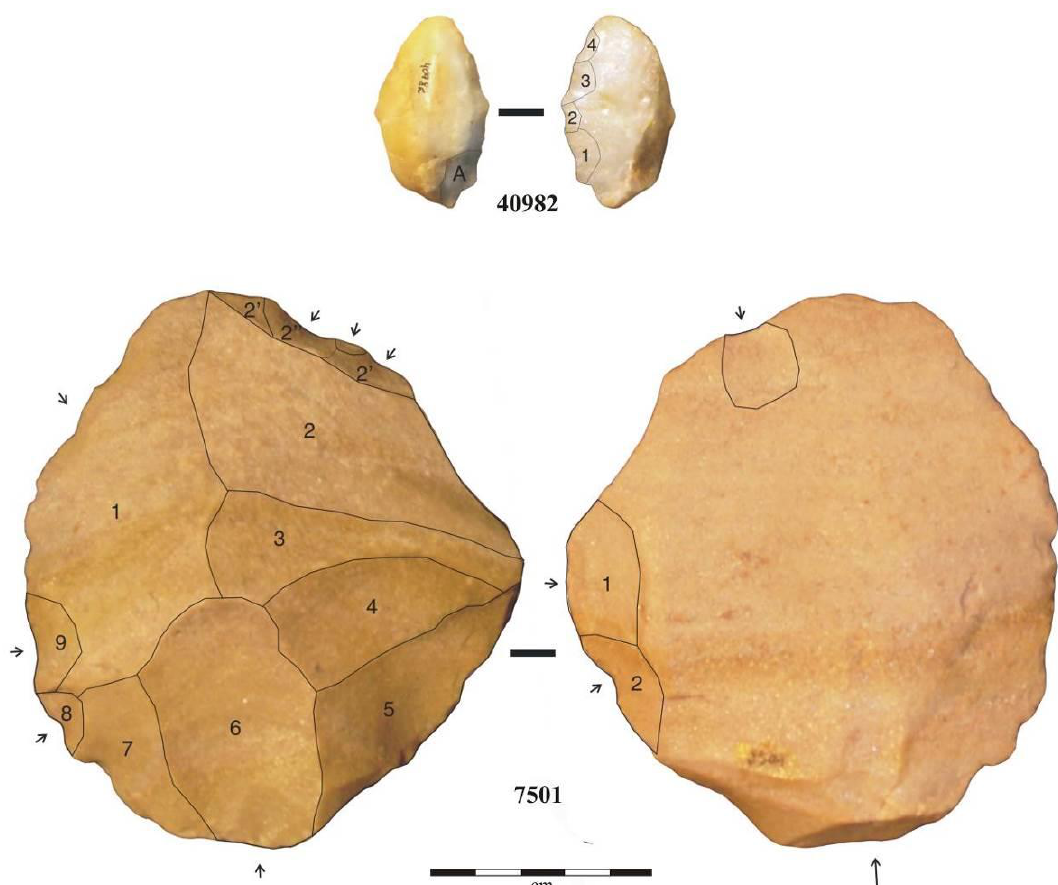
Figure 9. Flakes in quartz and quartzite from Pleistocene layer of Sitio do Meio, Pedra Furada 3 phase, older than uncal. 12,640 BP. Numbers refer to FUMDHAM inventory; retouched pieces: 40982 end-scraper in quartz; 7501: retouched flake in siltstone. (Photo by G.